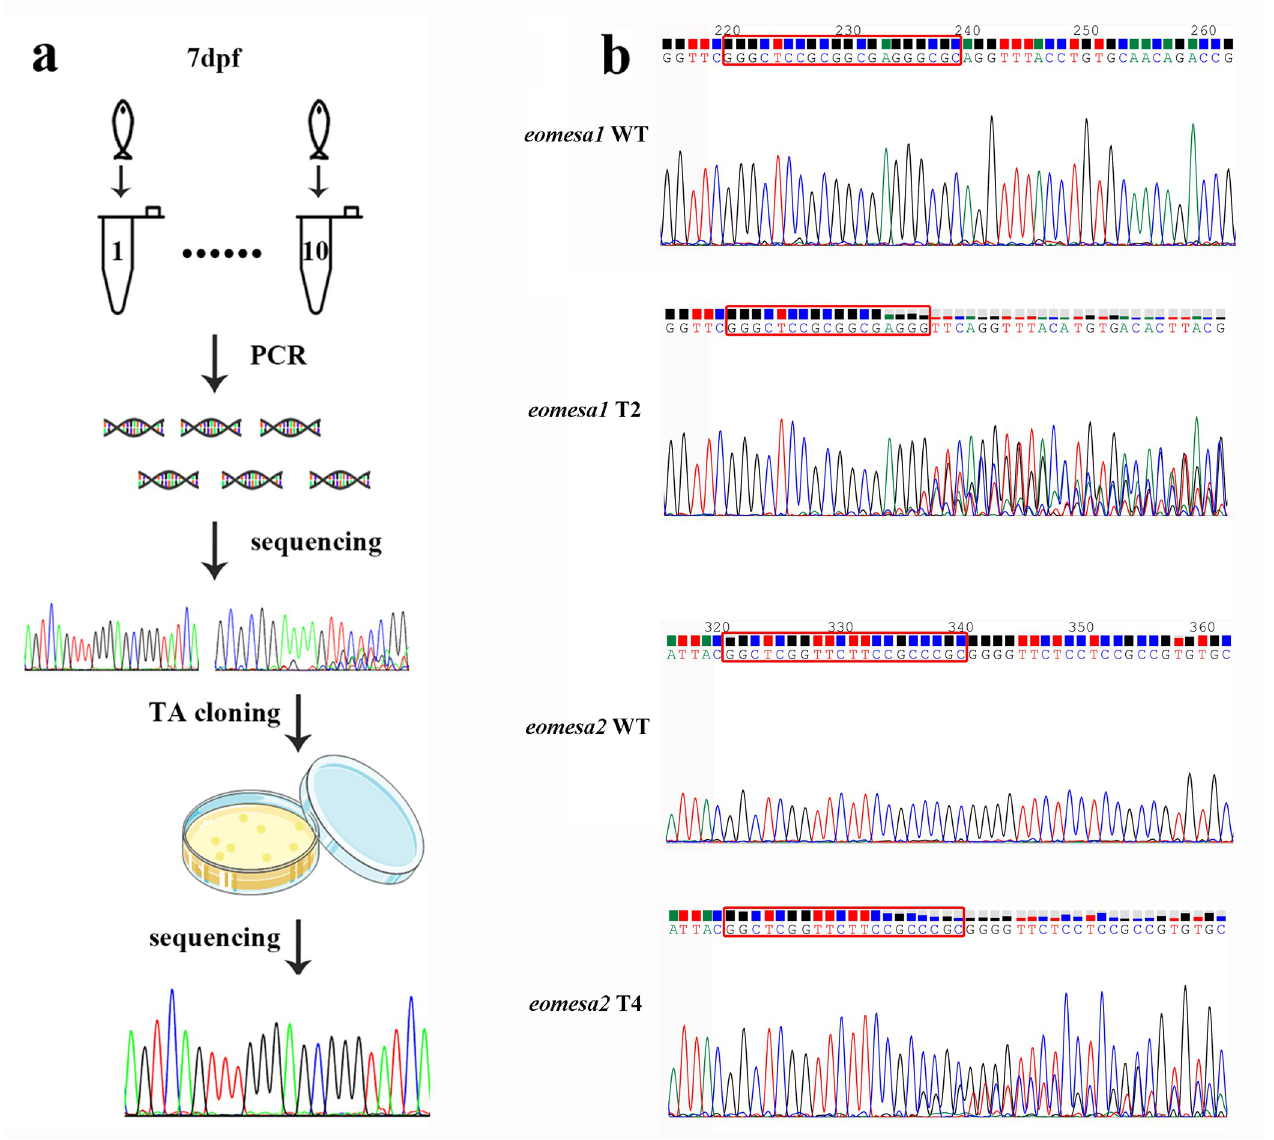
Fig 3. The efficiency of knock out at the eomesa1 and eomesa2 loci was evaluated by Sanger sequencing method at 7 days post fertilization. (a) The measurement procedure of gene editing efficiency includes population editing efficiency (E p ) and individual editing efficiency (E i ) on 7 dpf larvae. (b) Sanger sequencing chromatographs show overlapped peaks in the eomesa1 T2 and eomesa2 T4 sites in targeted individuals, and the ratio of peak heights from these overlapped peaks between WT and mutants implies the knockout efficiency. The red rectangles indicate the target bases.